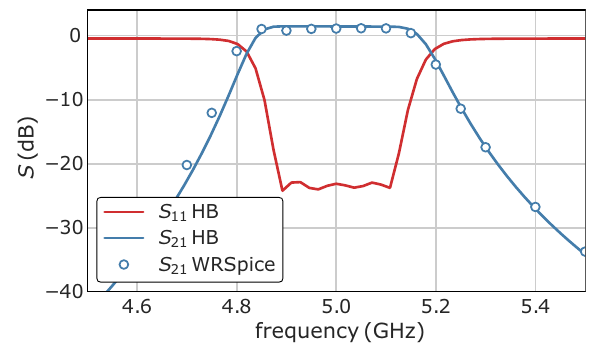
FIG. 16. Simulated S parameters of a matched parametric con- verter versus frequency referenced to the signal frequency. Solid lines are harmonic-balance simulations in Keysight ADS, circles are data from simulation in WRSpice. In the figure S 21 > 0 dB is a consequence of the Manley-Rowe relations [29], requiring power gain in an up-converting process that has unity photon